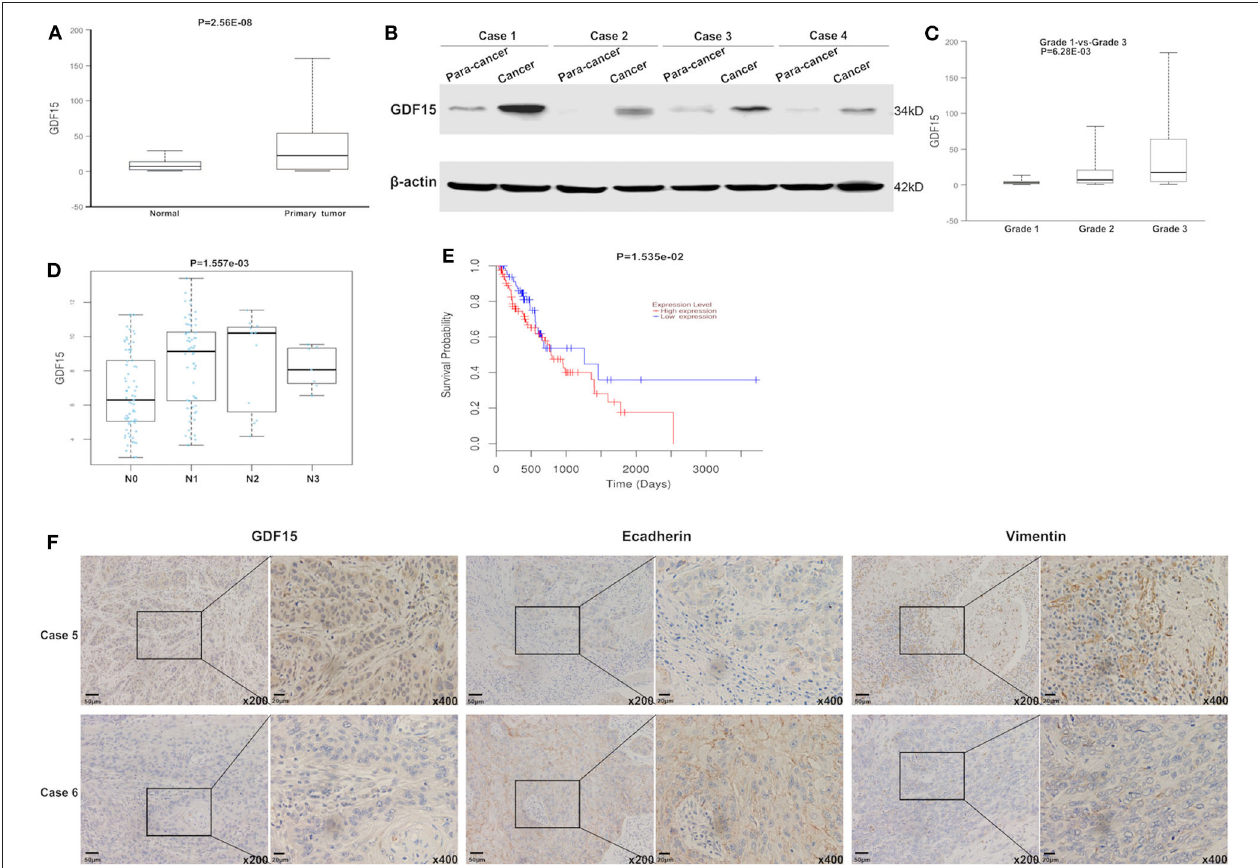
FIGURE 1 | GDF15 expression levels in EC and adjacent tissue. (A) GDF15 expression levels were analyzed using the EC dataset in TCGA. GDF15 expression levels in EC and adjacent tissues determined by western blotting (B) . (C–E) Correlation between GDF15 expression levels and tumor grade, lymphatic metastasis, and overall survival in EC analyzed using TCGA. (F) Expression levels of GDF15, E-cadherin, and vimentin in EC and adjacent tissues determined by